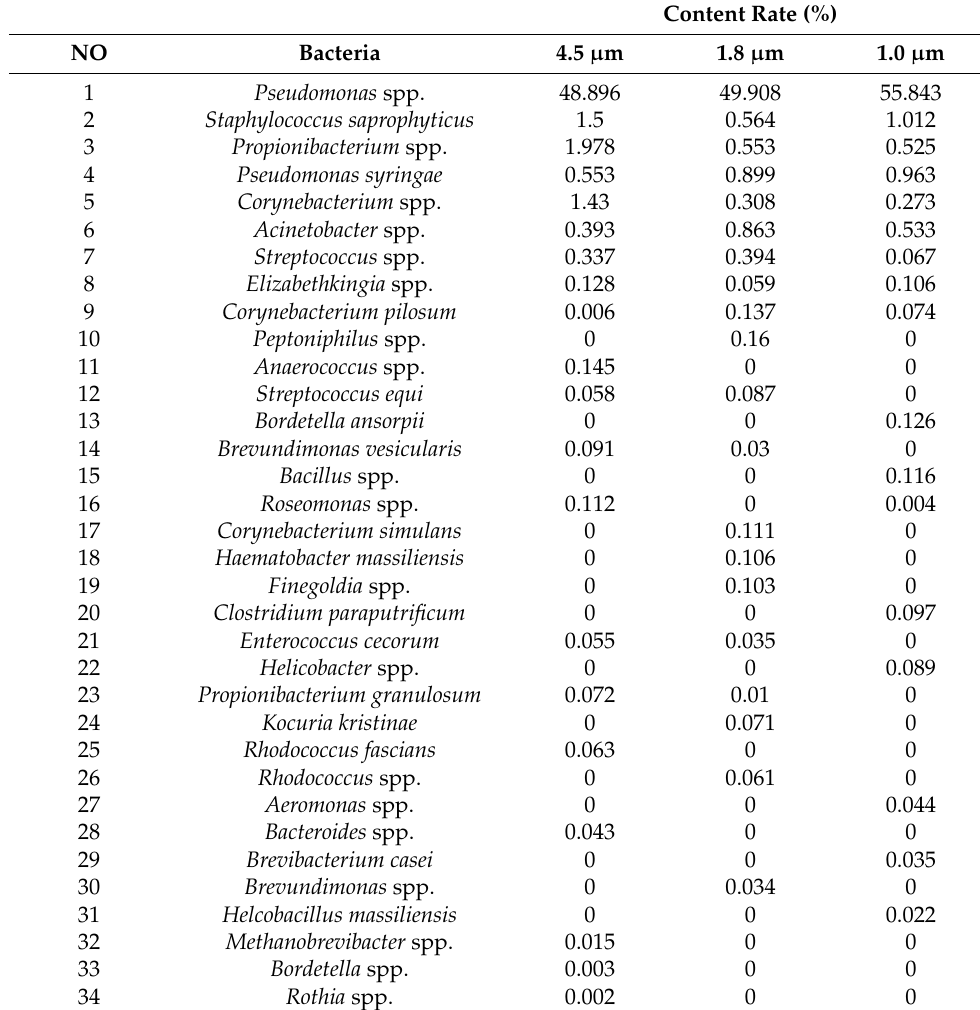
Table 5. Pathogenic bacteria identified from air samples collected by MMDs installed in the air suction devices. Content rates are mean values ( n = 3) of each OTU read number for the total NGS